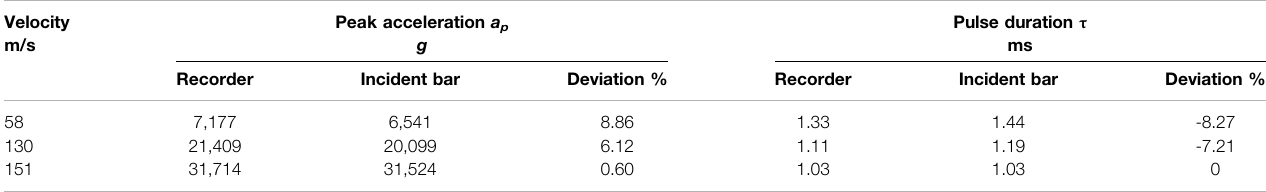
TABLE 4 | Comparison of impact load data.